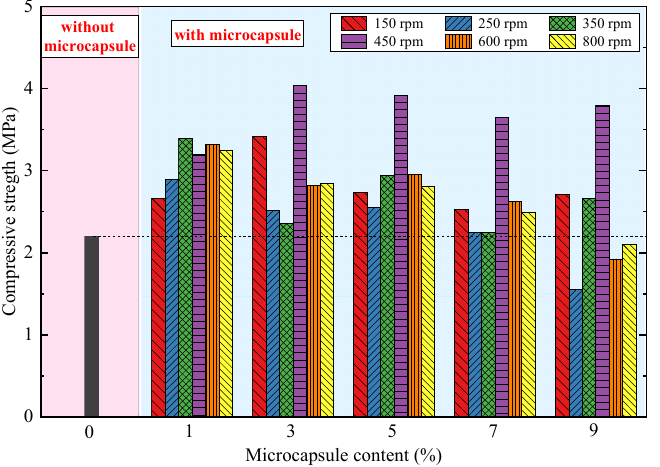
Figure 5. Compressive strength versus microcapsule content.